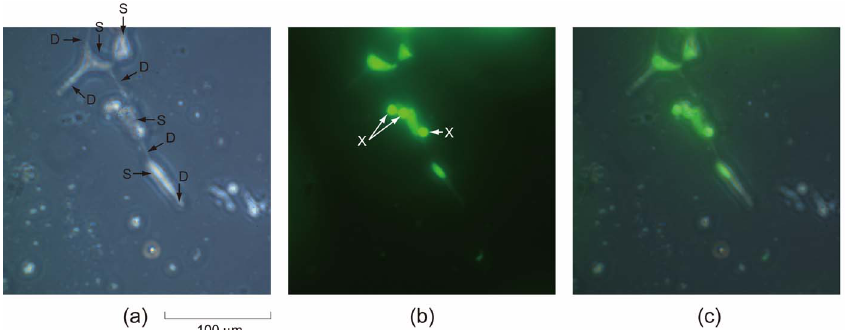
Fig. 3 (a) Phase contrast photograph, (b) fluorescent one, and (c) merged one of (a) and (b) of cultured neurons over P(VDF-TrFE) film modified by collagen and fabricated on glass substrate. Symbols D, S, and X indicate dendrite, soma, and dead cell,